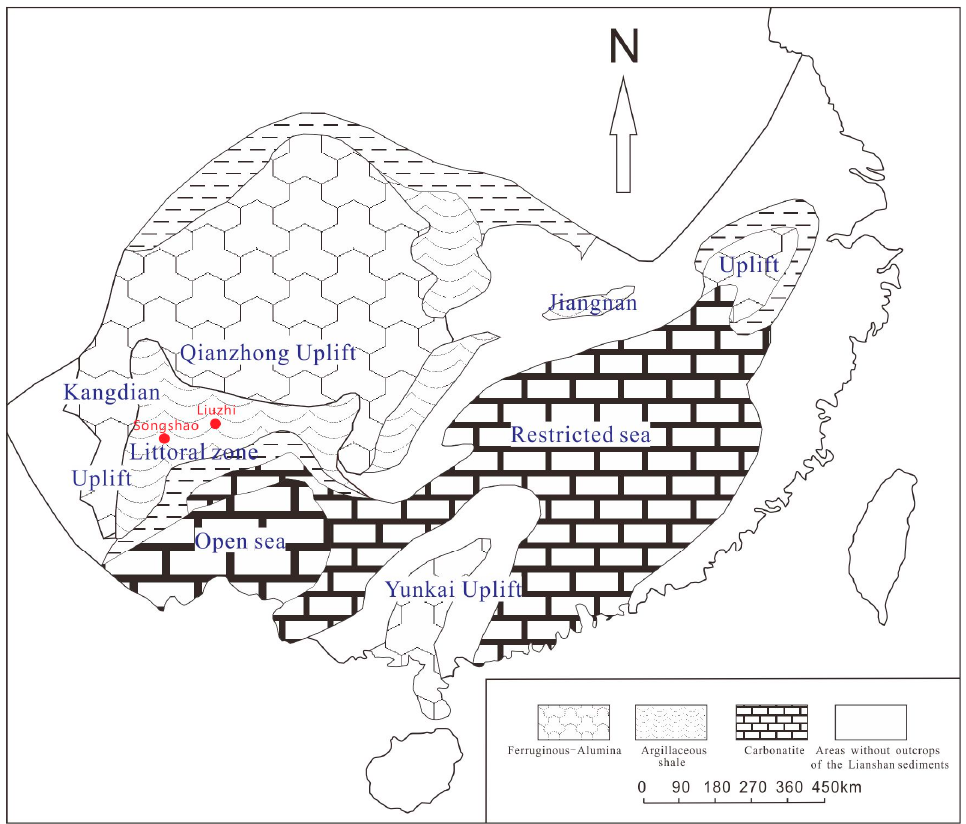
Figure 8. Sketch map of lithological facies and paleogeography in the study area during the Liangshan Stage. Modified from [73,74].